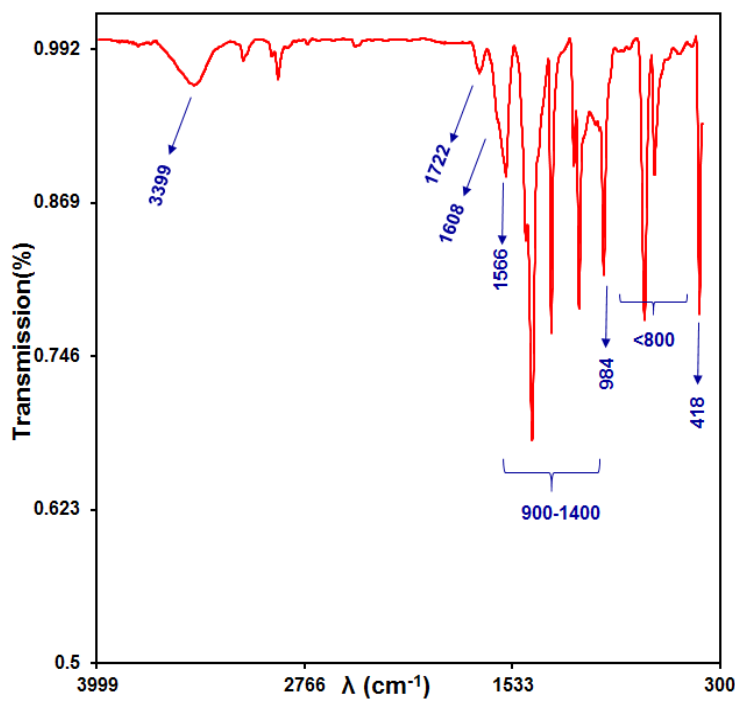
Figure 2. FTIR spectrum of the GO/ZIF-67 nanocomposites.